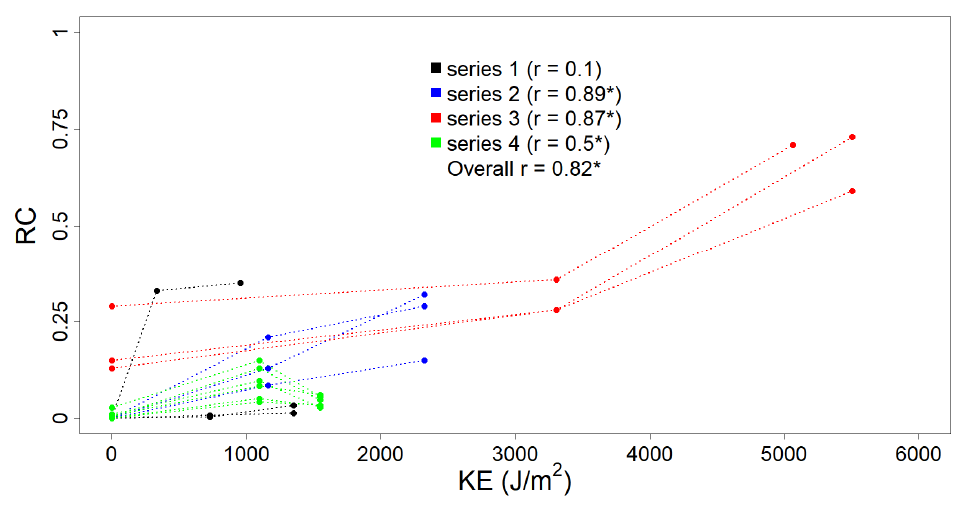
Figure 7. Scatterplot of KE in J/m 2 and runoff coefficient RC. The pertinence to the four data series is highlighted with colours. Correlation values with p < 0.05 are marked with *.